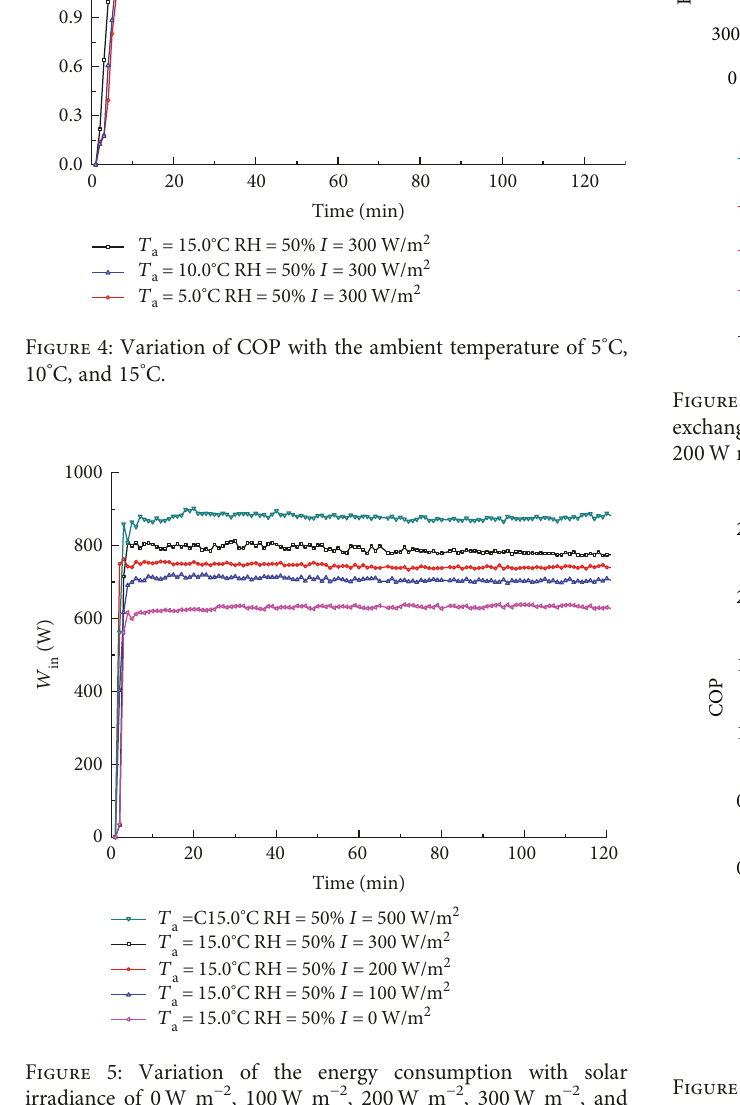
Figure 7: Variation of COP with solar irradiance of 0 W m − 2